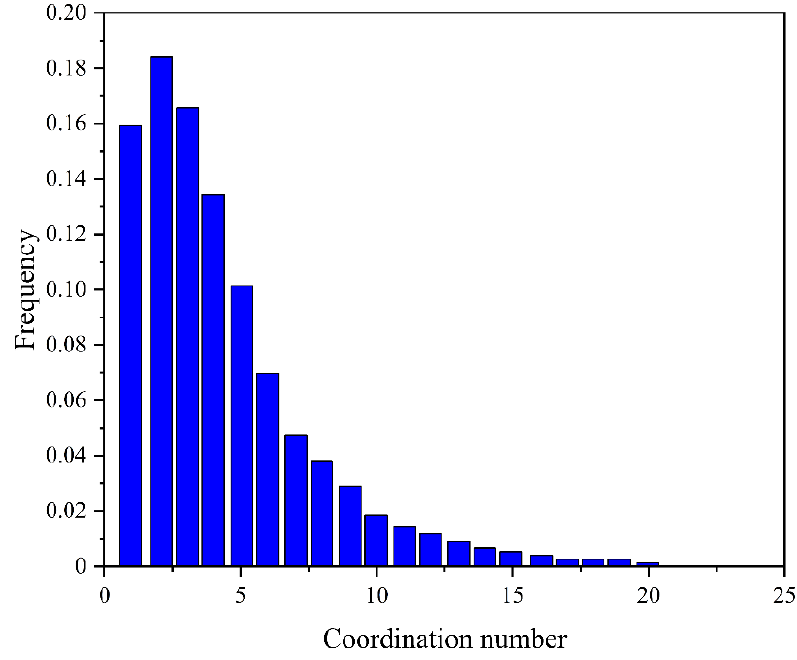
Figure 5. Distribution of coordination numbers.